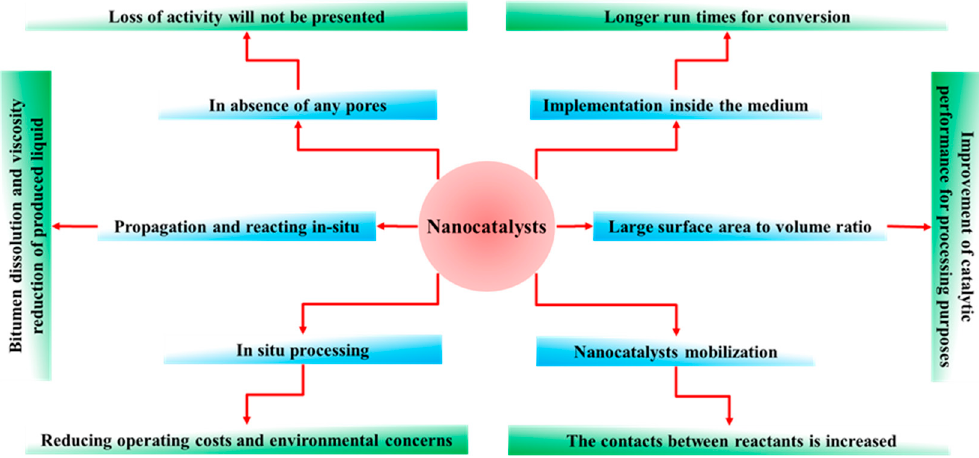
Figure 14. The advantages with the usage of nanocatalysts compared with traditional catalysts.